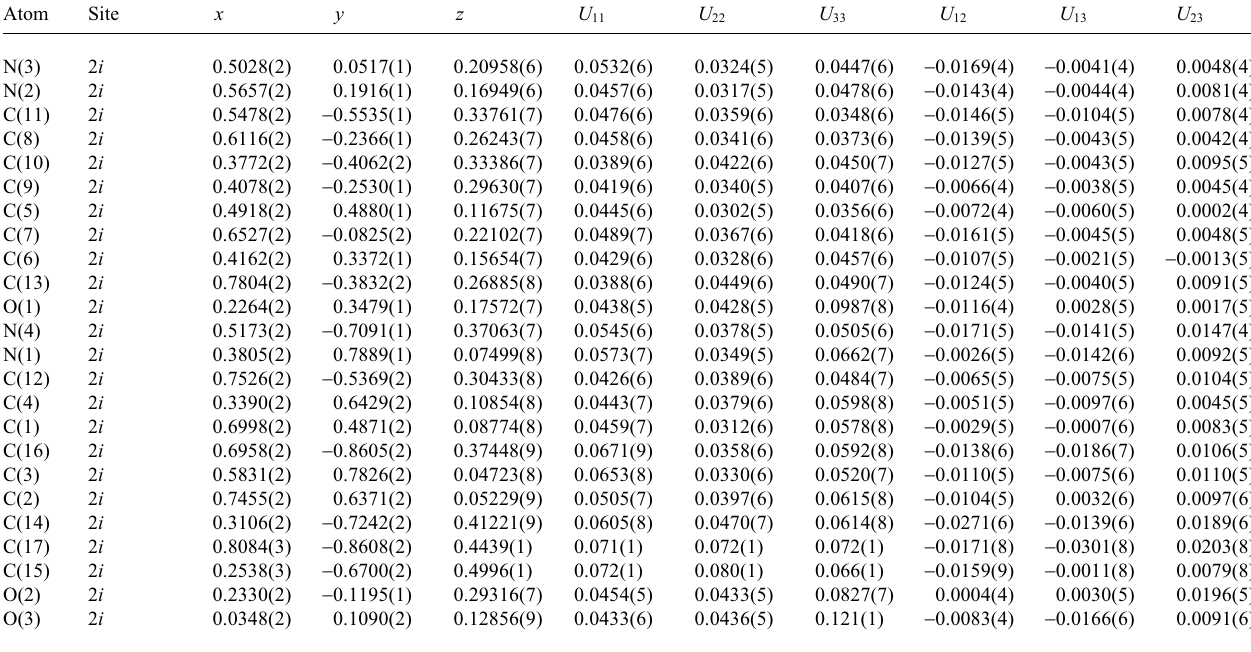
Table 3. Atomic coordinates and displacement parameters (in Å 2